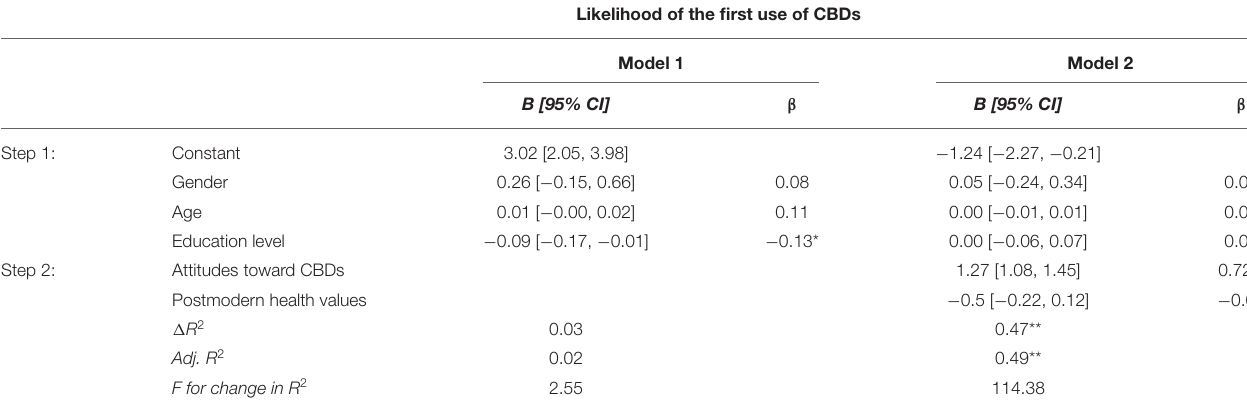
TABLE 5 | Hierarchical multiple regression for predicting the first use of cannabinoids